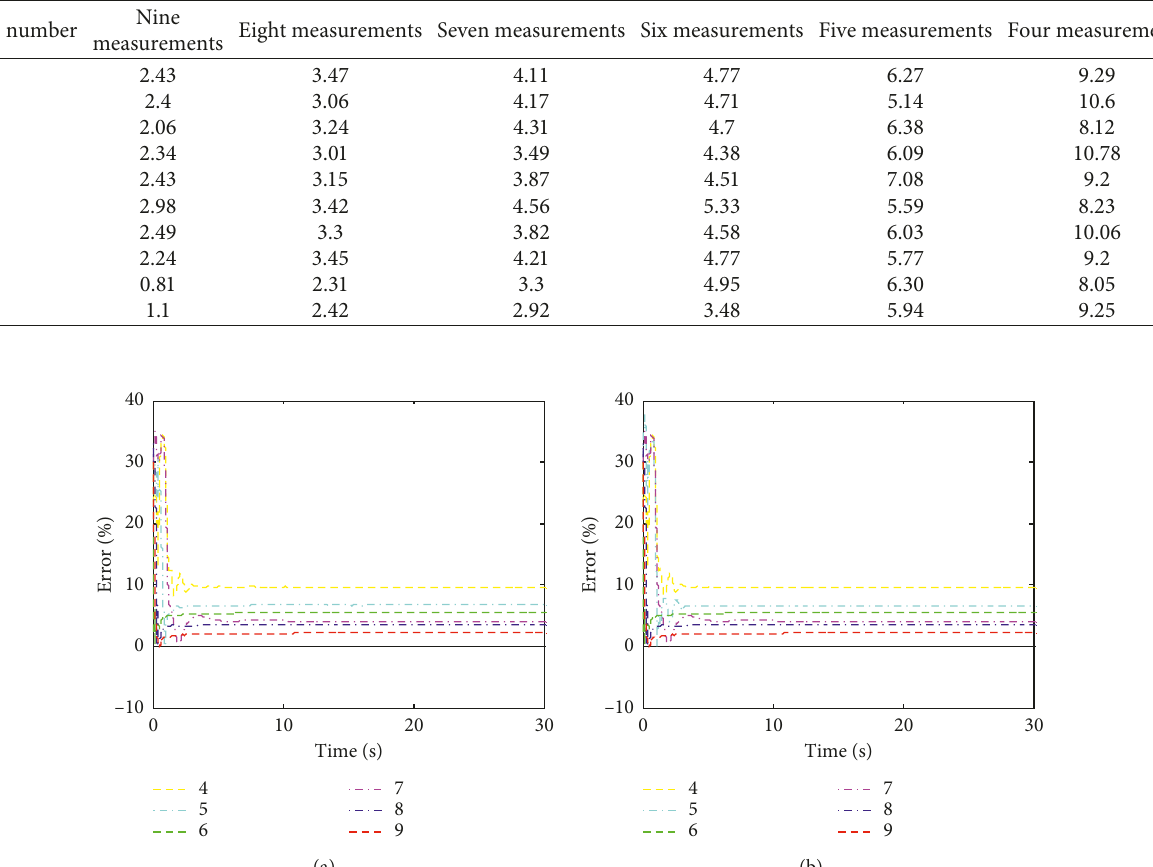
Figure 8: Time histories of the estimated wind load for different numbers of measurements on the (a) fifth floor and (b) tenth floor. Table 7: RMS errors of wind load for different numbers of measurements.